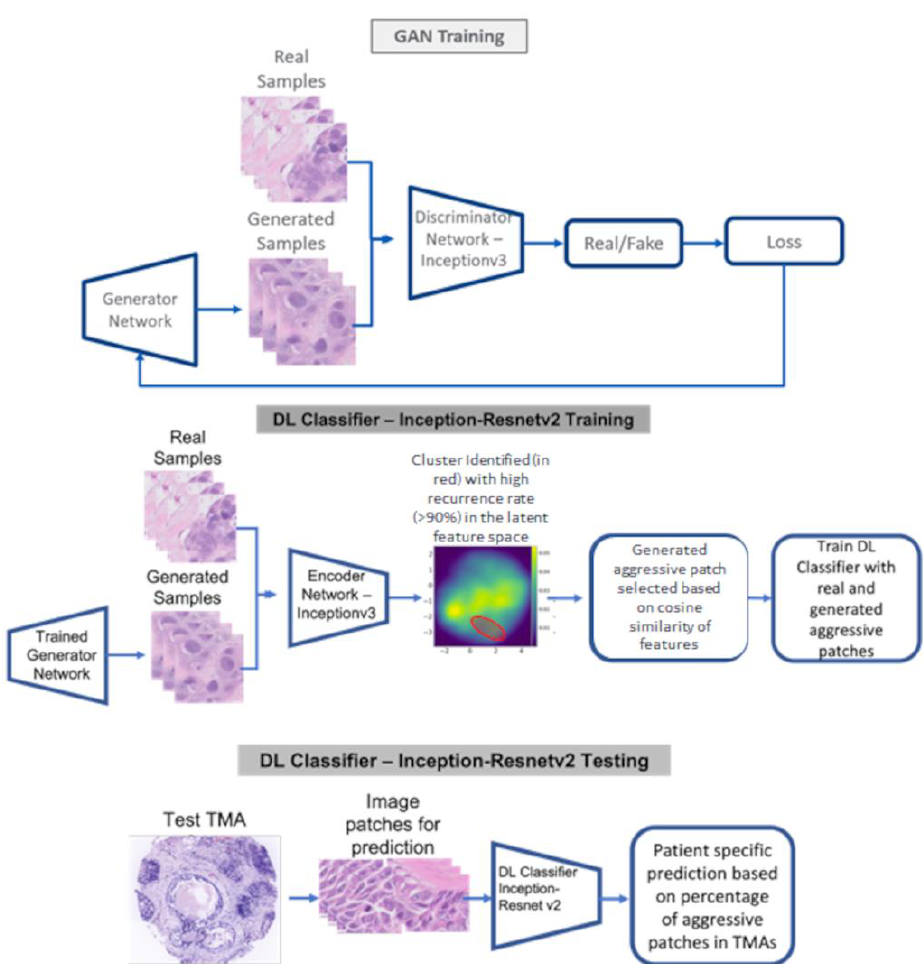
Figure 1. The architecture of the generative adversarial network (GAN) and its modification to develop the L-GAN framework. During GAN training, a generative model was developed that automatically generates high quality H & E image patches. The generated image patches that are similar to original aggressive image patches in latent feature space cluster were automatically selected based on the cosine similarity of the feature vectors; During DL classifier training (Inception-Resnetv2), real H & E image patches along with generated aggressive image patches were used. The trained DL classifier was then used to predict aggressiveness of a new image patches.